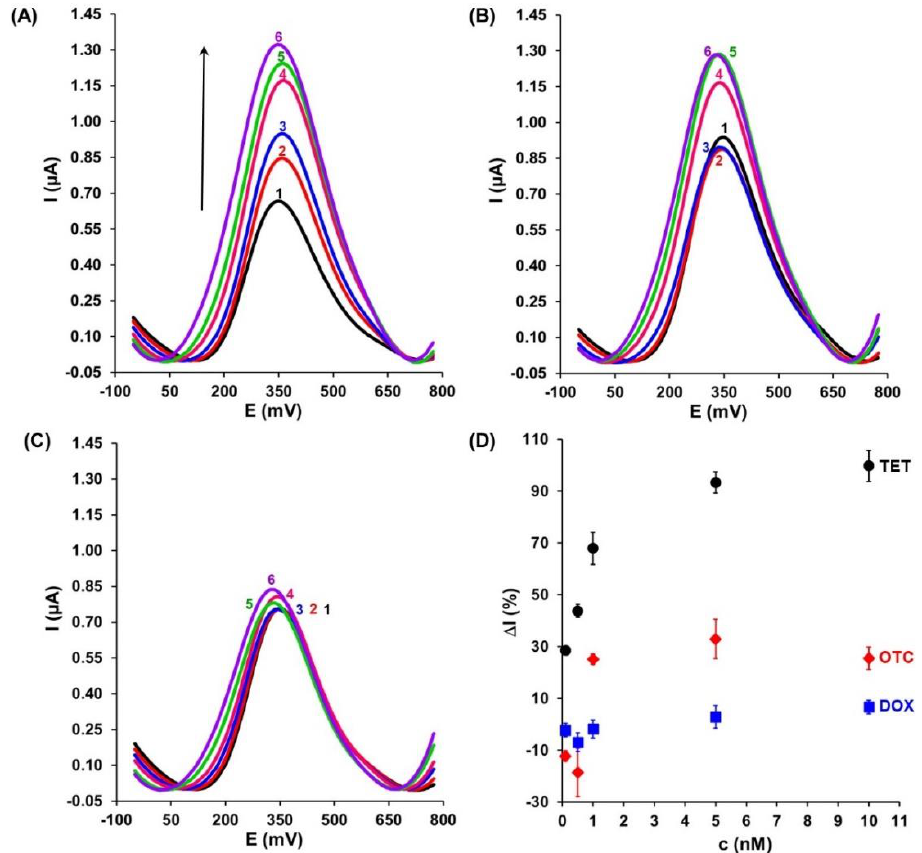
Figure 4. Example of square-wave voltammograms registered for gold electrodes modified with Au-S-Apt-Fc/MCH upon interaction with ( A ) TET, ( B ) OTC, and ( C ) DOX. Black curve ( 1 ) before and next curves after 1 h interaction with antibiotics at particular concentrations: 0.1 nM ( red , 2 ), 0.5nM ( blue , 3 ), 1.0 nM ( pink , 4 ), 5.0 nM ( green , 5 ), and 10.0 nM (viol et , 6 ). ( D ) Relative intensity of current ( Δ I) vs. concentration of ( ● ) TET, ( ♦ ) OTC, and ( ■ ) DOX for gold electrodes modified with Au-S-Apt-Fc/MCH. Table 2. The values of relative intensity of current ΔI [%] measured with electrodes modified with the HS-Apt-Fc/MCH layer after incubation with TET, OTC, and DOX.